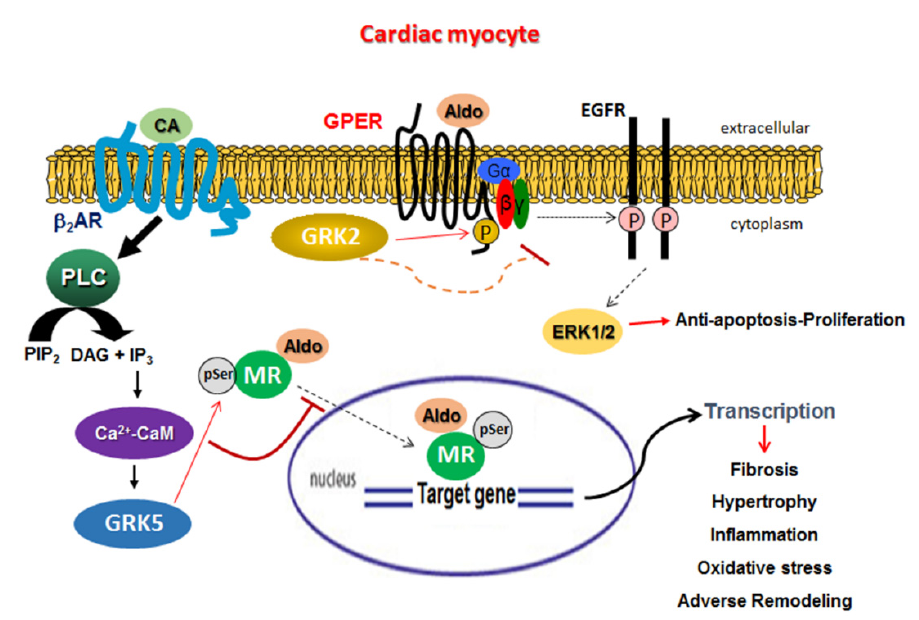
Figure 7. Schematic illustration of the signaling interplay between GRK5 and MR as well as between GRK2 and GPER inside cardiac myocytes. GRK5, activated by the cardiac β 2 AR via PLC β -Ca 2 + -CaM signaling, translocates to the cytoplasm to phosphorylate the MR and inhibit its transcriptional activity as a result of the Aldo–MR complex’s cytoplasmic-nuclear shuttling blockade. GRK2, on the other hand, phosphorylates and desensitizes the agonist-activated GPER at the plasma membrane. Aldo: Aldosterone; CA: Catecholamine; P: Phosphorylation; pSer: Phosphorylated serine; PLC: Phospholipase C; PIP 2 : Phosphatidylinositol 4,5-bisphosphate; DAG: Diacylglycerol; IP 3 : Inositol 1,4,5-trisphosphate; CaM: Calmodulin; ERK: Extracellular signal-regulated kinase. See text for more details and for all other molecular acronyms’ descriptions. Solid arrows denote direct activation / action, dotted arrows multi-step activation or translocation, and (cid:97) denotes inhibition.